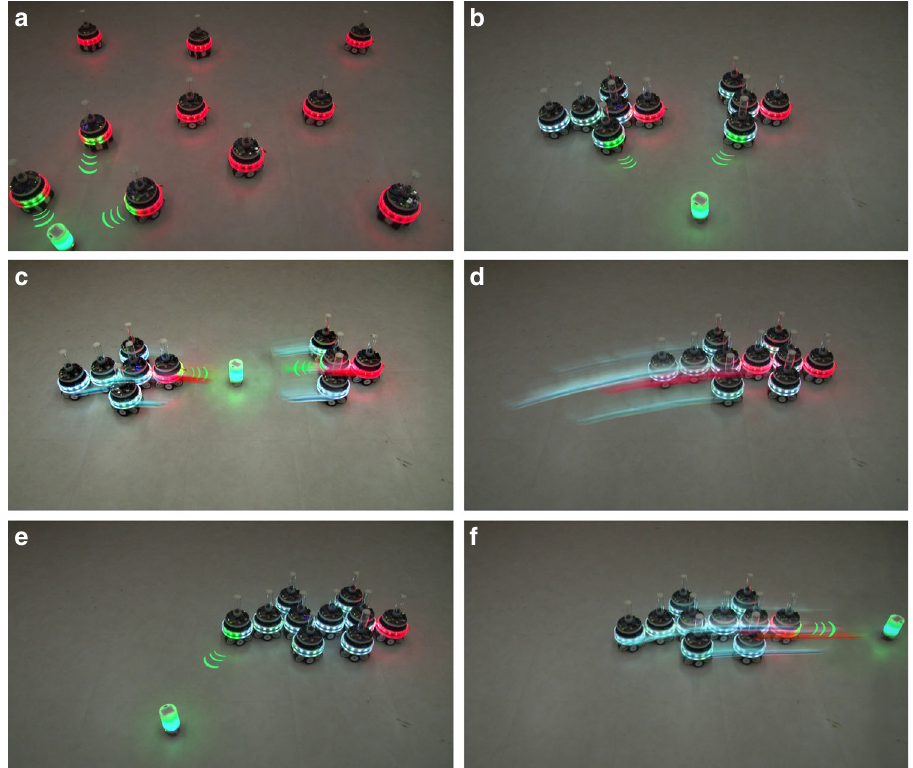
Fig. 2 Morphology-independent sensorimotor coordination. Independently of shape and size, MNS robots display consistent sensorimotor reactions to a stimulus, while autonomously merging their bodies and robot nervous systems. Photos are snapshots from a single experiment (Supplementary Movie 2) in which ten MNS robots respond to a moving stimulus. We design the behavioral rules for the robotic units so that when the green stimulus enters a robot ’ s sensor range, the robot ‘ points ’ at the stimulus by illuminating its three closest green LEDs (in a composite MNS robot, these are the closest LEDs on the closest constituent robotic unit). For clarity, we have added concentric green lines as overlays to highlight the pointing direction, and brain units have their LEDs illuminated in red . When the stimulus is ‘ too ’ close (i.e., proximity to any part of the MNS robot ’ s body exceeds a threshold), the robot retreats from the stimulus. a Each robotic unit is an independent MNS robot in its own right. The stimulus provokes a reaction in three of the robots. b The ten MNS robots have merged to form two larger MNS robots. These newly formed robots are composite MNS robots each consisting of several robotic units. However, the two MNS robots are independent robots in their own right — they each have a single brain unit and a single robot nervous system. Both robots point at the stimulus. c The two MNS robots retreat from the stimulus. d The two MNS robots autonomously merge to form a larger MNS robot with a single brain unit. e The newly formed 10-unit MNS robot points at the stimulus. f The MNS robot retreats from the